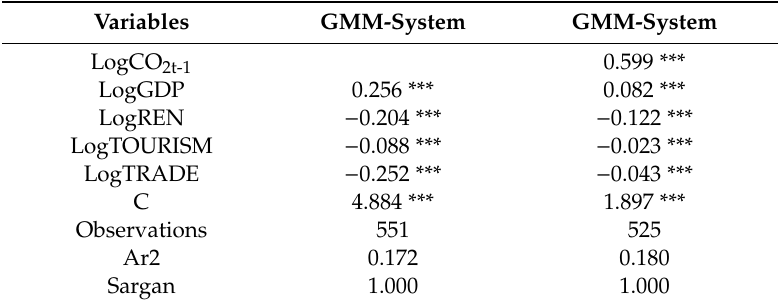
Table 7. Generalized Method of Moments (GMM)-System